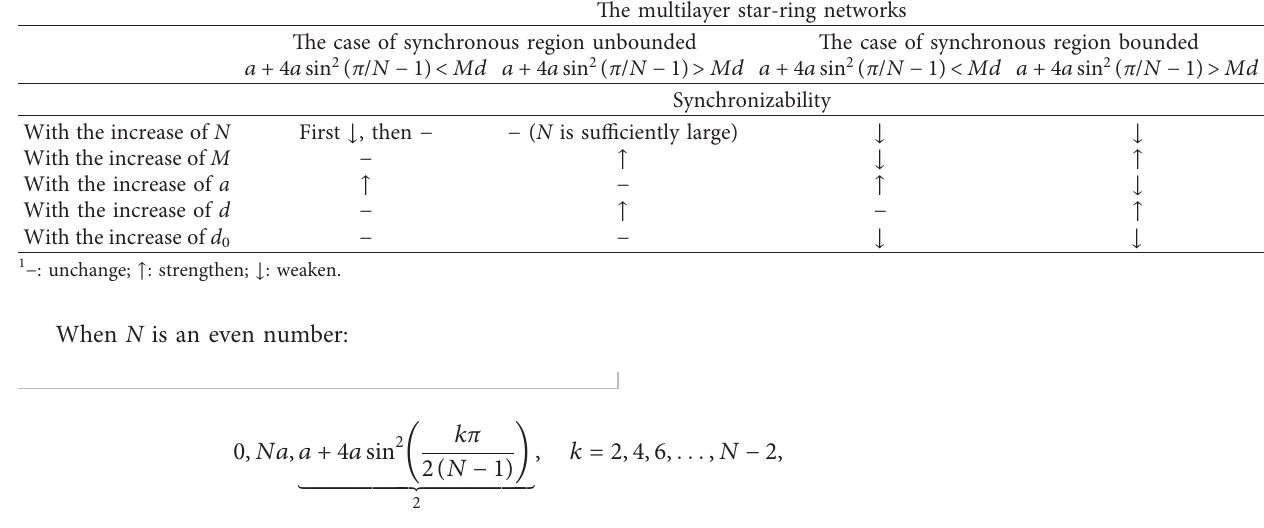
Table 3: When d 0 ≠ d , the synchronizability of the multilayer star-ring networks varies with N , a , d , d 0 , and M . The multilayer star-ring networks The case of synchronous region